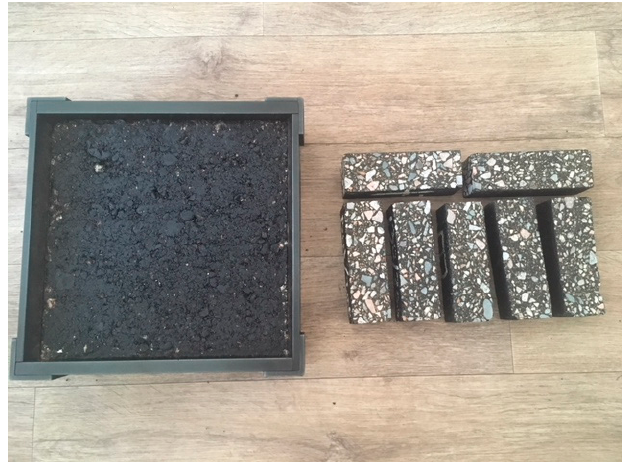
Figure 4. Asphalt concrete samples: in the shape of a square slab with dimensions 305 × 305 × 50 mm (left); in the shape of a rectangular prism with dimensions 5 × 5 × 50 mm (right).